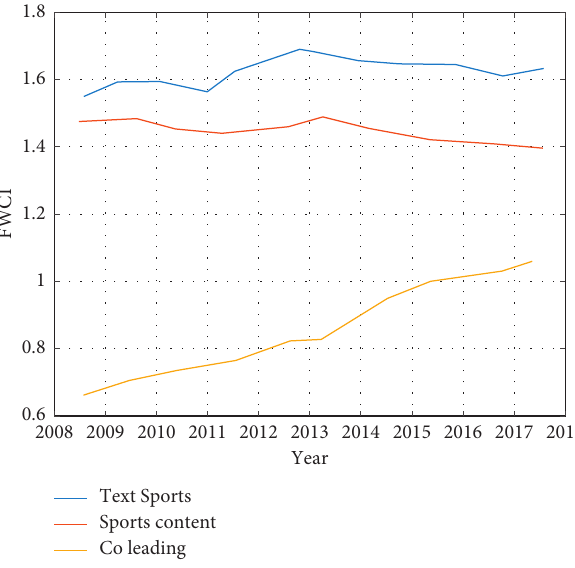
Figure 14: Trend of FWCI by type of output,